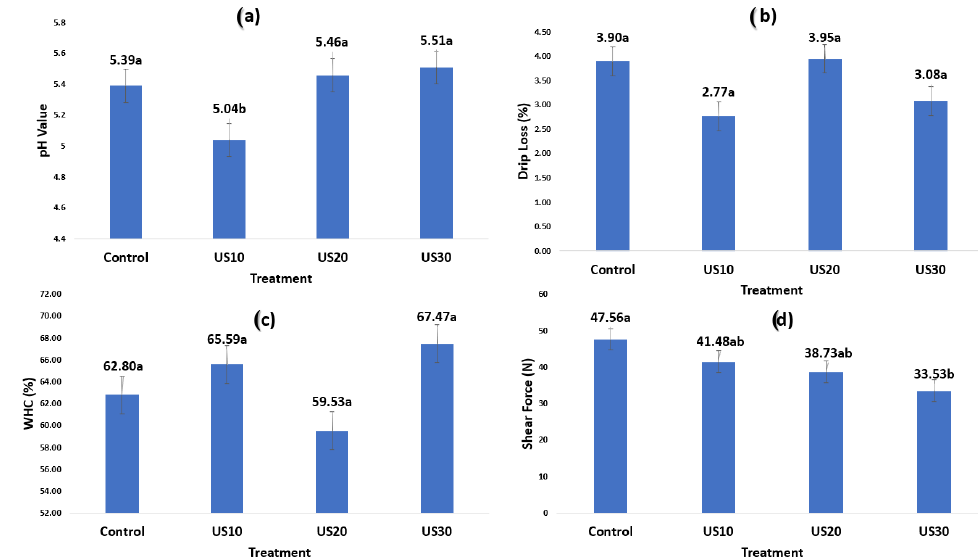
Figure 1. Meat quality traits after high-frequency focused ultrasound application. ( a ) pH value, ( b ) drip loss, ( c ) water holding capacity (WHC), ( d ) shear force. Treatments: Control = meat without ultrasound treatment, US10 = meat with the application of 10 min ultrasound, US20 = meat with the application of 20 min ultrasound, US30 = meat with the application of 30 min ultrasound. a,b Different letters within the same trait denote significant difference ( p < 0.05).